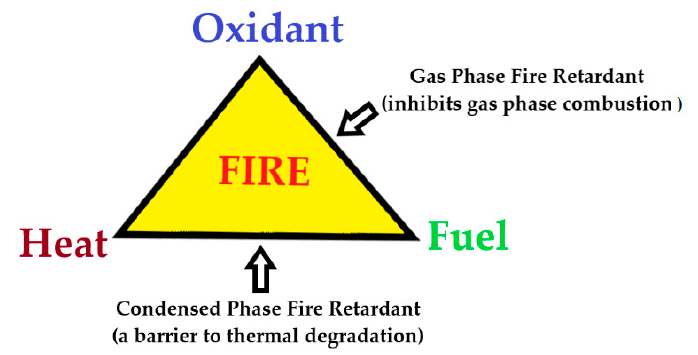
Figure 3. A diagram representation of fire-retardant (FR) actions interrupting a polymer combustion cycle.